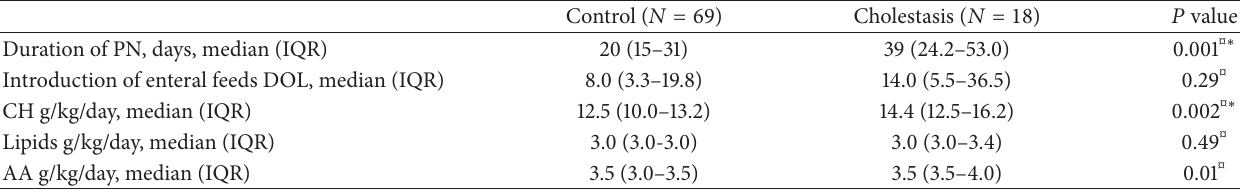
Table 2: Composition and duration of PN.